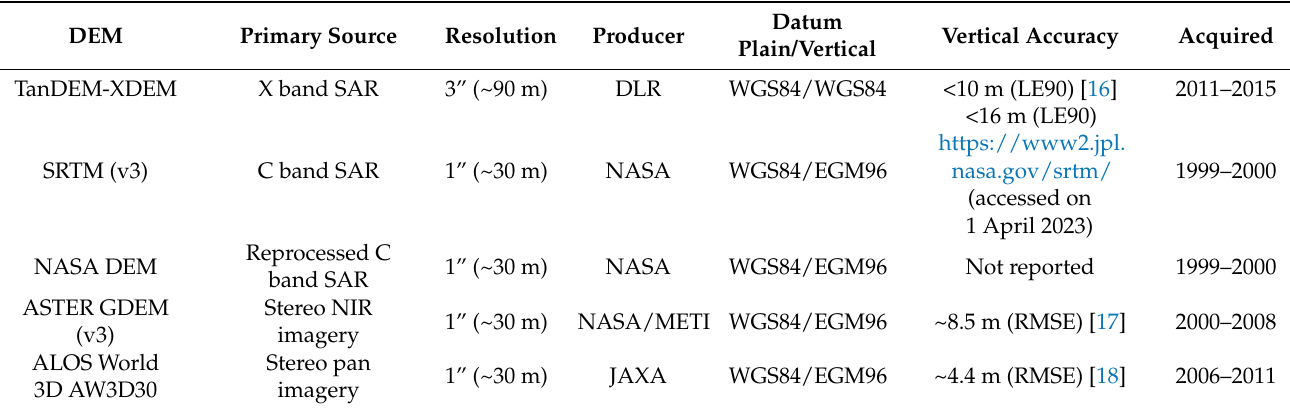
Table 1. Basic parameters of DEM datasets used in this